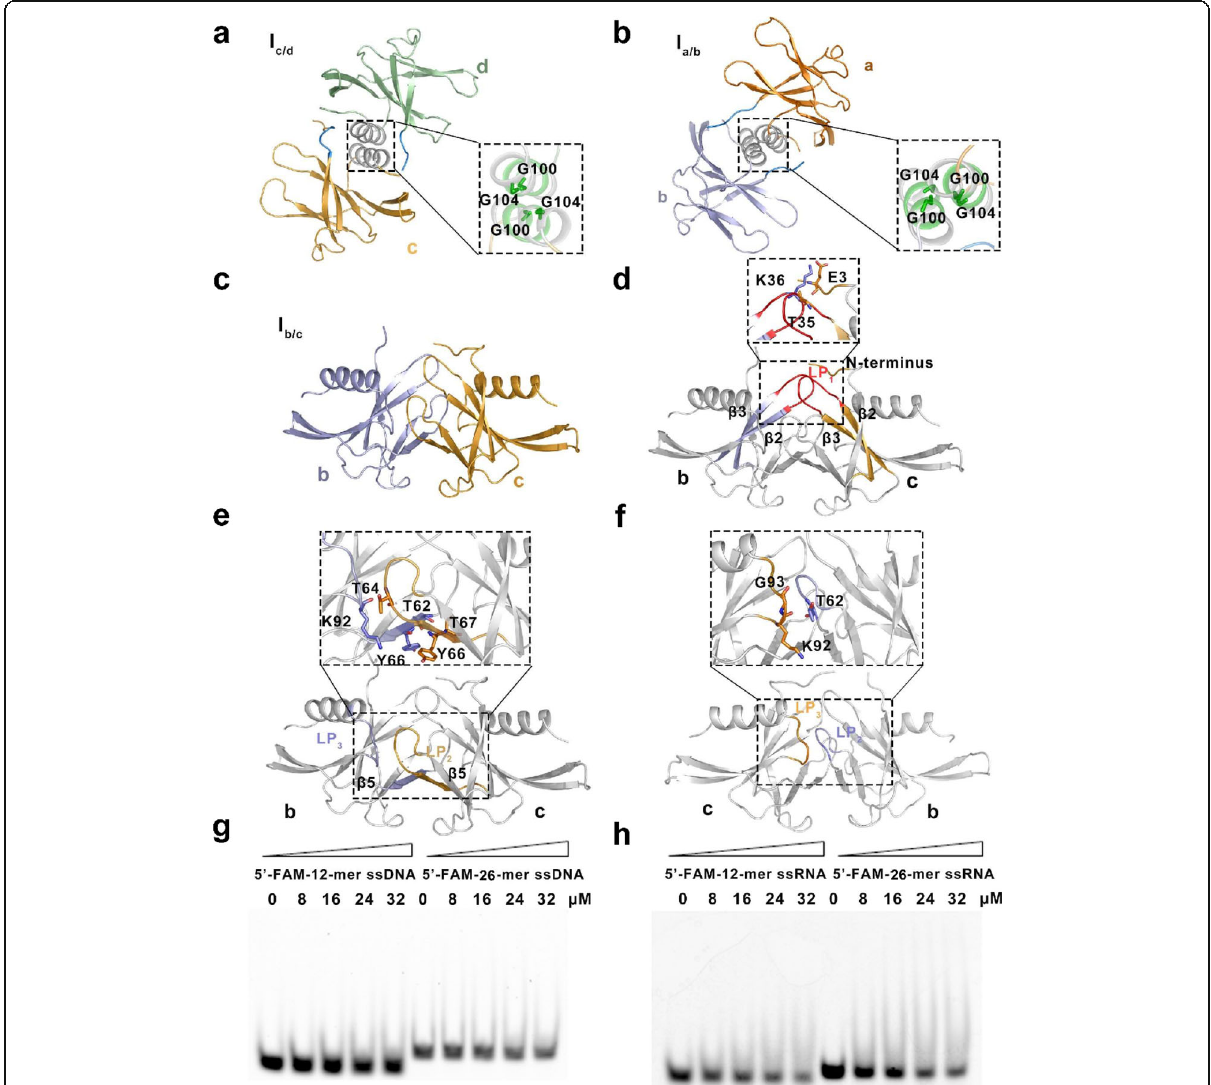
Fig. 3 Details of structure of the SARS-CoV-2 nsp9 tetramer and function in nucleic acid binding. a , b Details of I c/d and I a/b in the helix interface. The molecules in these two interfaces are shown as cartoons and colored and labeled as in Fig. 2a. The expanded boxed area to the right shows a detailed view of the critical residues in the I c/d and I a/b interfaces, which are shown as sticks. c Molecules involved in I b/c . The molecules in this interface are shown as cartoons and colored and labeled as in Fig. 2a. d – f Detailed views of the first, second, and third contact regions in interface I b/c , respectively. The secondary structures of each contact region are colored and labeled according to Fig. 2a and the critical residues in each region are shown as sticks. g Single-stranded DNA (ssDNA)-binding abilities of SARS-CoV-2 nsp9, as determined by electrophoretic mobility shift assay. h Single-stranded RNA (ssRNA)-binding abilities of SARS-CoV-2 nsp9. The length of ssDNA, the state of SARS-CoV-2 nsp9, and the concentration of proteins used in the reaction system are indicated above the